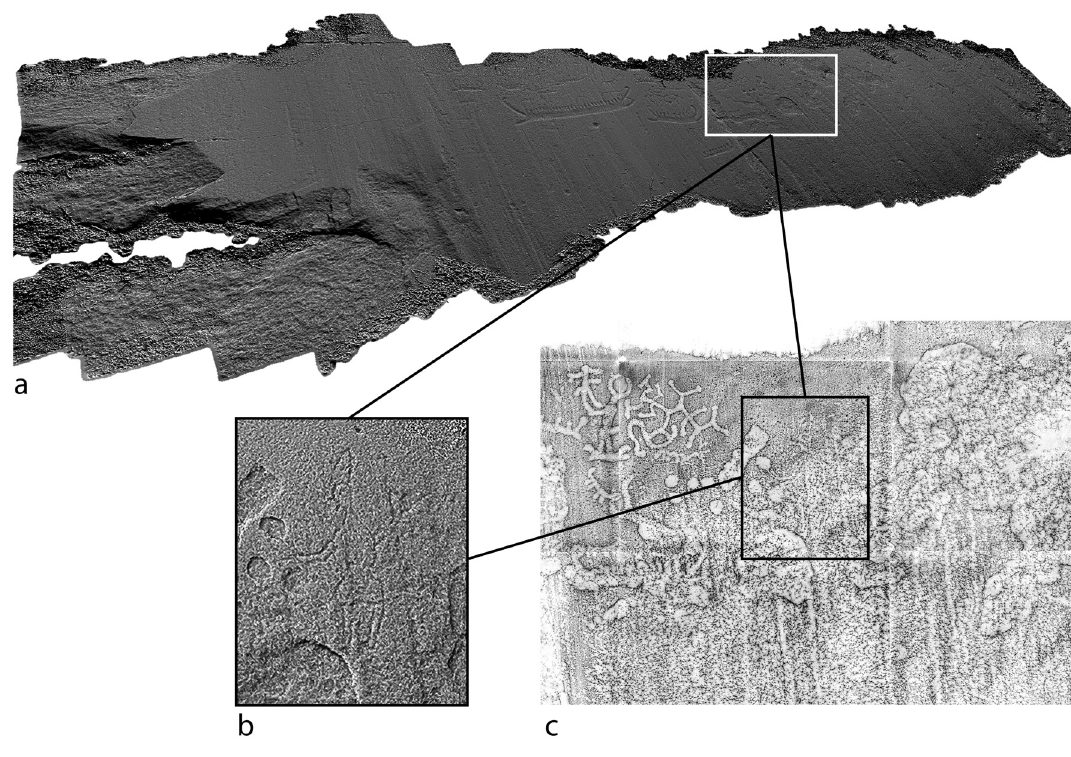
Figure 3. a. SfM of the entire Hoghem, RAÄ Tanum 160:1 panel by RP; b. Anthropomorphic figure in eroded zone, SfM with radiance scaling filter (80%) by RP & CH; c. Frottage by Tanums Hällristningsmuseum